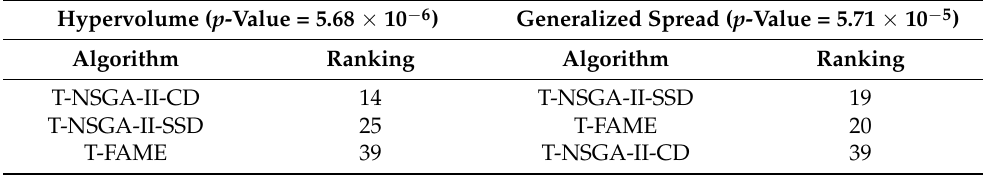
Table 12. Friedman ranks of all algorithms with hypervolume and generalized